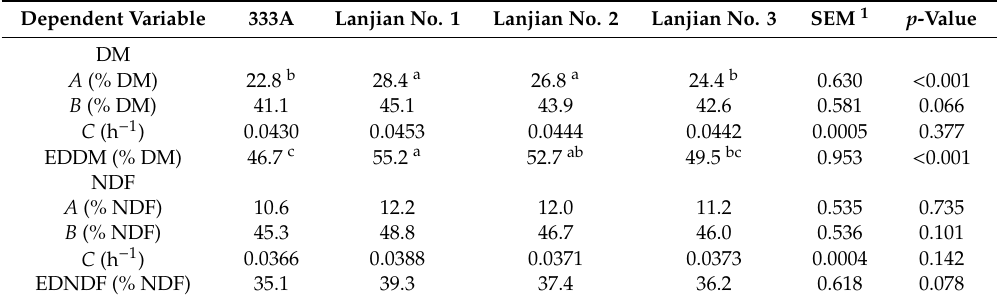
Table 6. Influence of variety on in situ ruminal degradation kinetics of dry matter (DM) and neutral detergent fiber (NDF) of straw in four common vetch